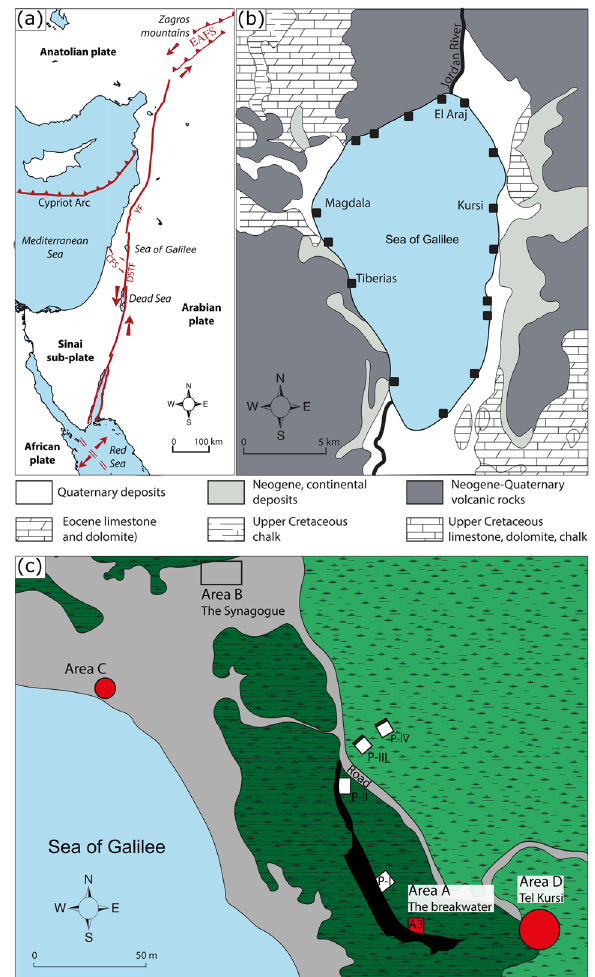
( b ) Geological map of the Sea of Galilee 15 . The black squares indicate the main built harbors on the shore of the lake 16 . ( c ) Kursi Beach general plan of the excavation. Original measurements and drawing by M. Edelcopp and B.